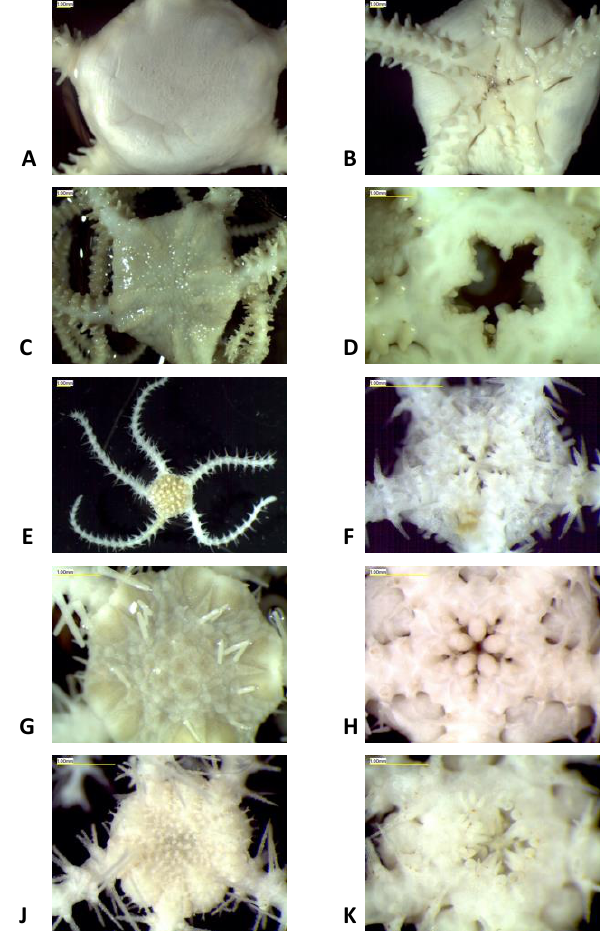
Figure 2 . Morphology of the five species in dorsal and ventral views. ( A , B ): Ophiomyxa serpentaria Lyman, 1883; ( C , D ): Ophiolebes bacata Koehler, 1921; ( E , F ): Ophiomitrella clavigera (Ljungman, 1865); ( G , H ): Ophiactis abyssicola (M. Sars, 1861); ( I , J ): Ophiacantha cuspidata Lyman,